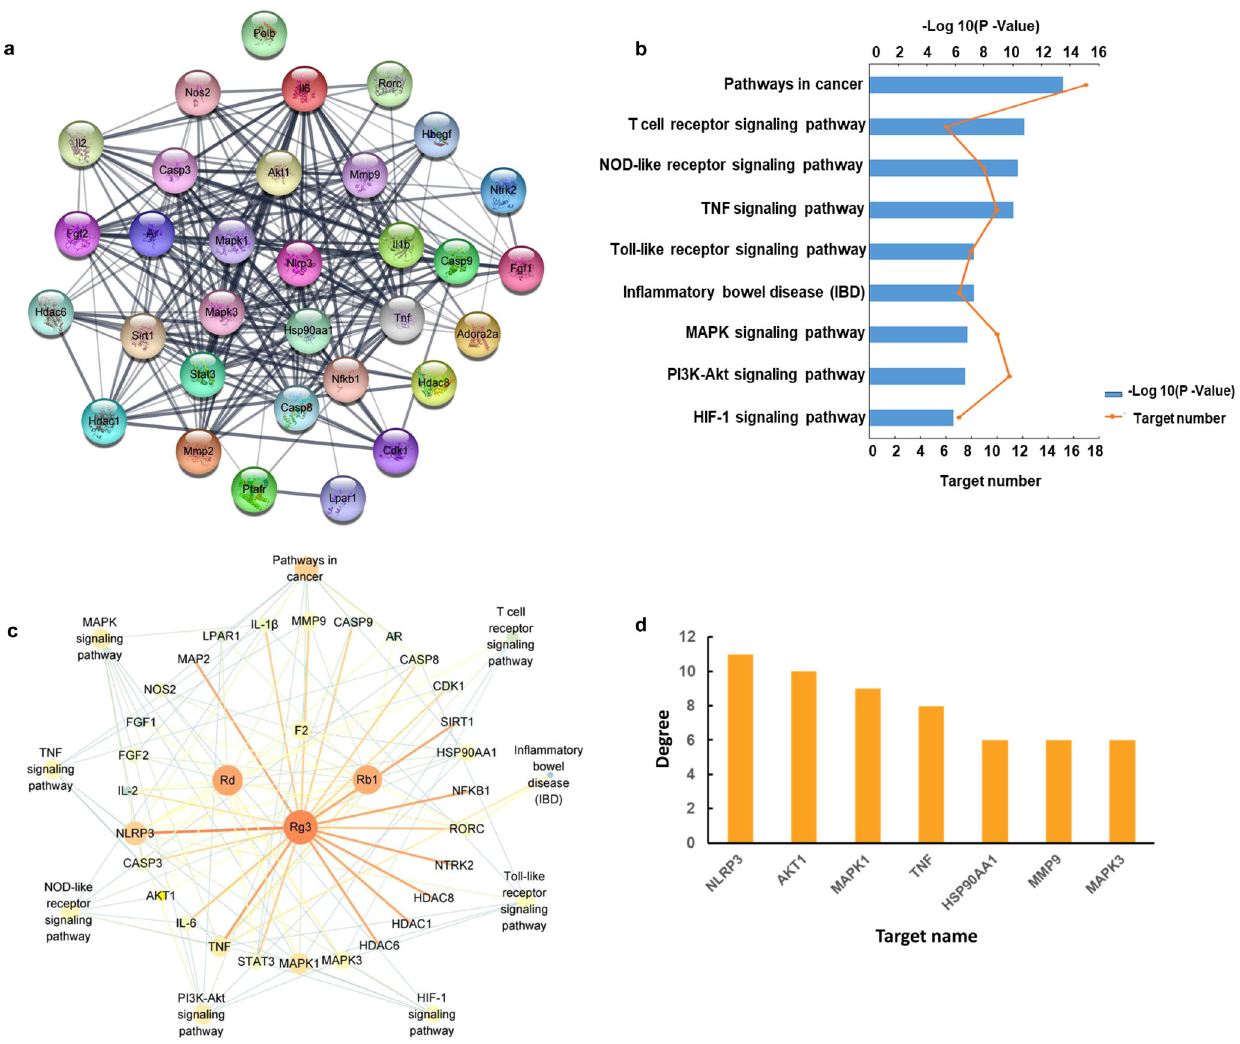
Fig. 3 Systems pharmacology predicted NLRP3 as a key shared target in mediating the immunomodulatory activity of ginsenoside analogues. a PPI network analysis, b KEGG analysis, c compounds-targets-pathways network and d centrality algorithm analysis of the